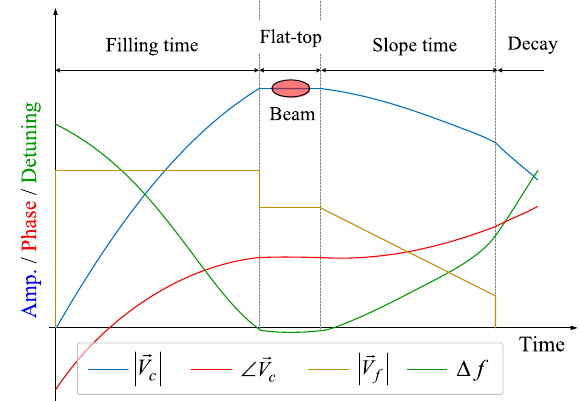
FIG. 3. Typical amplitude and phase pulse pattern of the cavity voltage ( V c ), amplitude pattern of the cavity forward voltage ( V f ), and the corresponding lorentz force detuning (LFD) during the cERL beam commissioning.